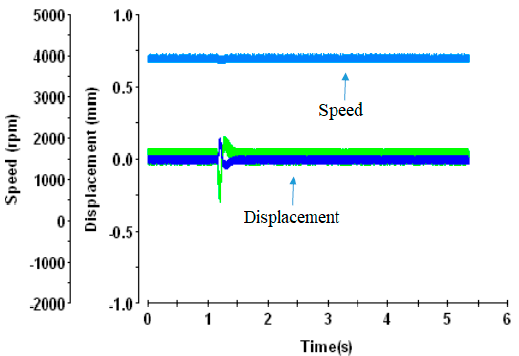
Figure 19. Influence of external impulse force.